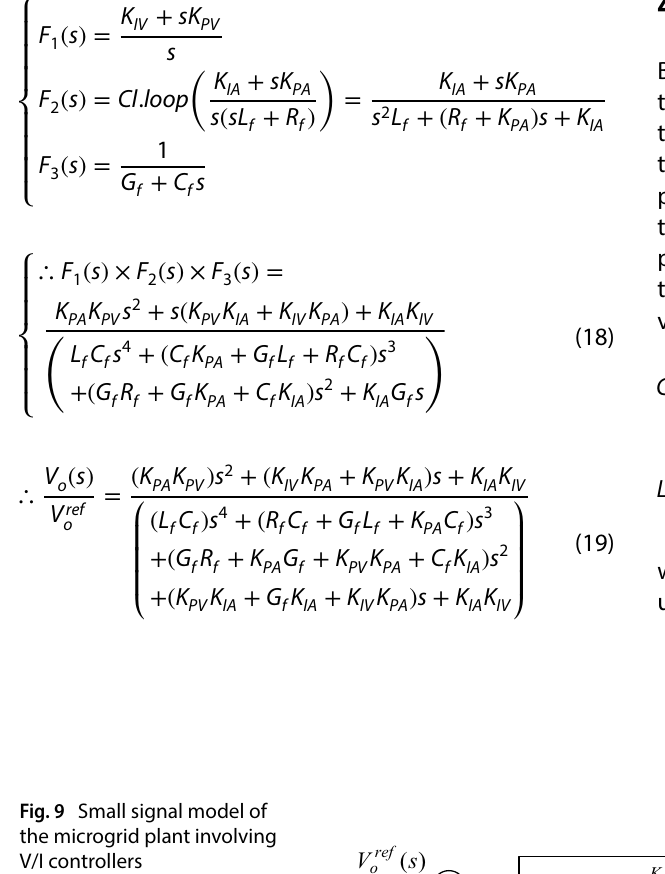
Fig. 9 Small signal model of the microgrid plant involving